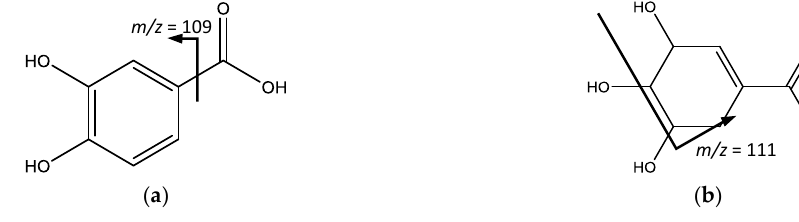
Figure 7. ( a ) Protochatechuic acid and ( b ) Shikimic acid structure and main fragments.